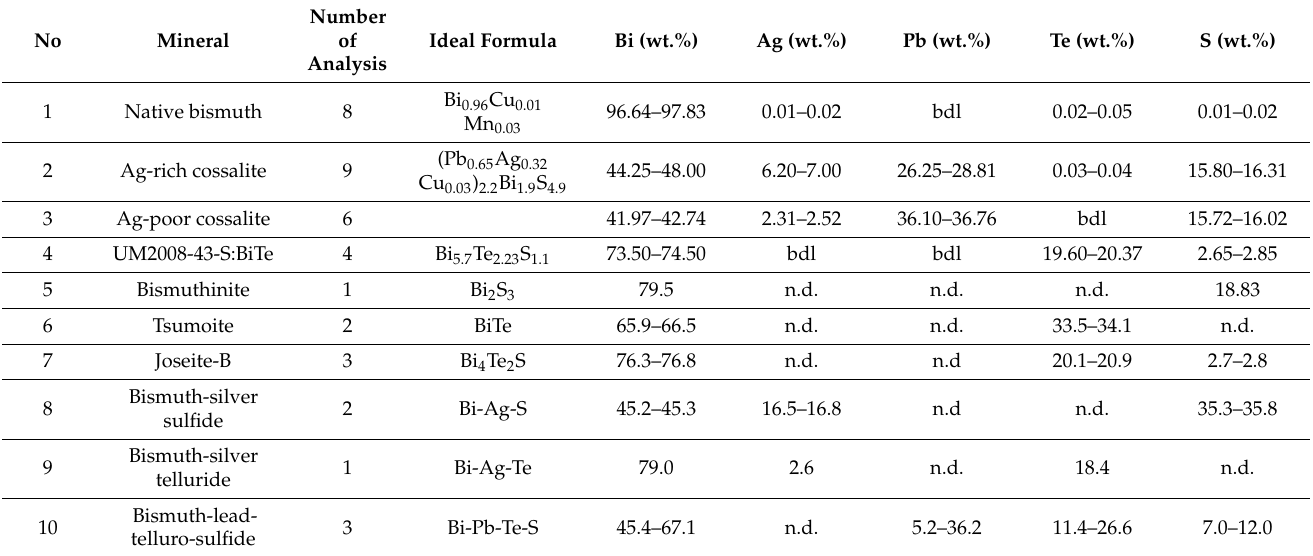
Table 1. Summary of several Bi-bearing minerals found in the Ruwai